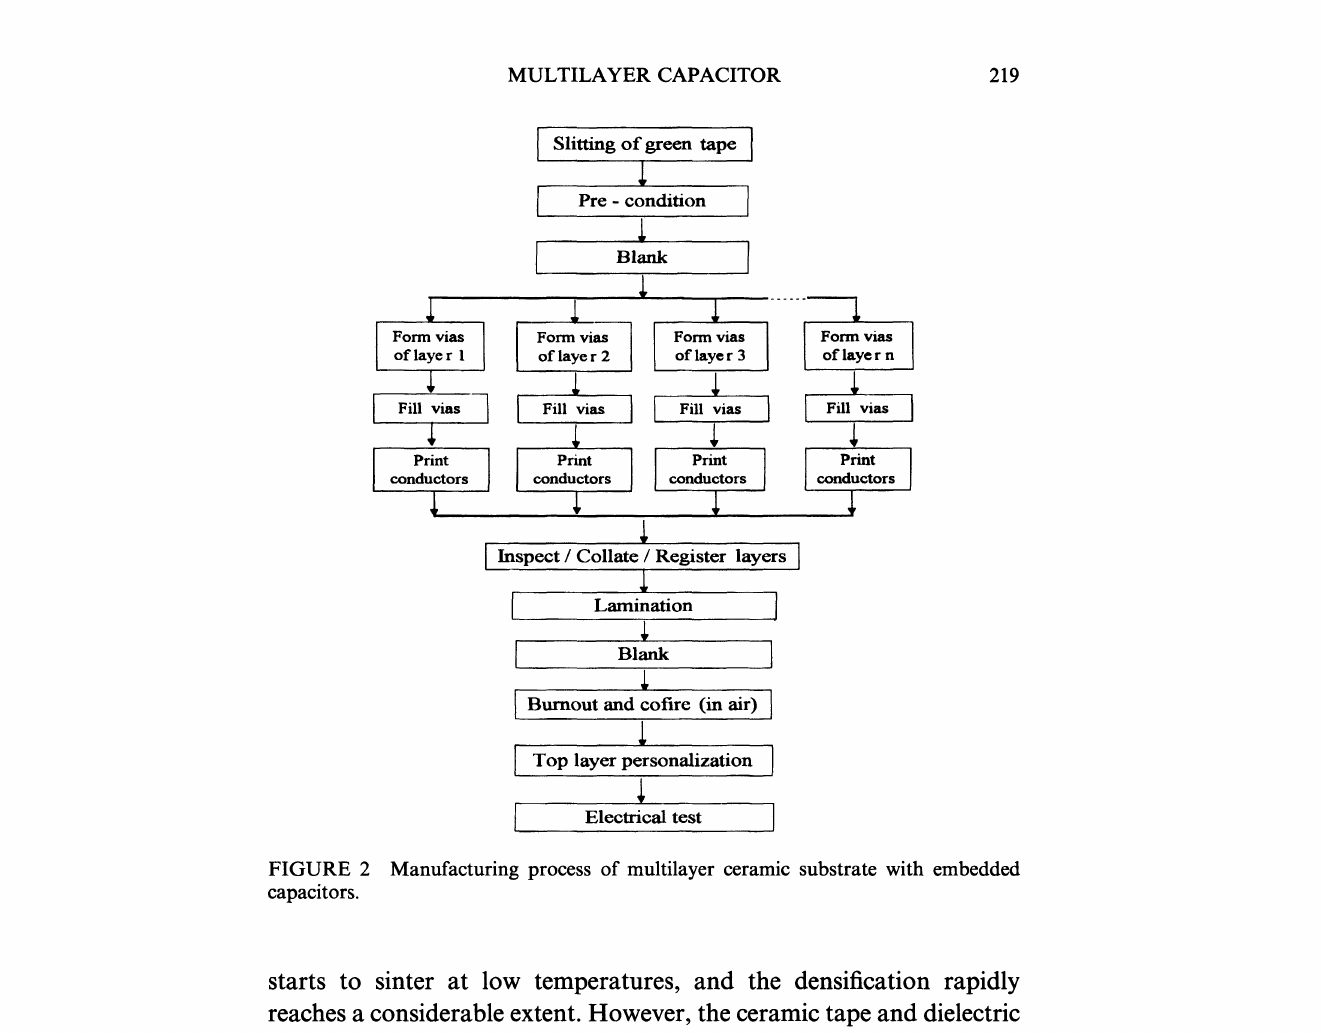
FIGURE 2 Manufacturing process of multilayer ceramic substrate with embedded